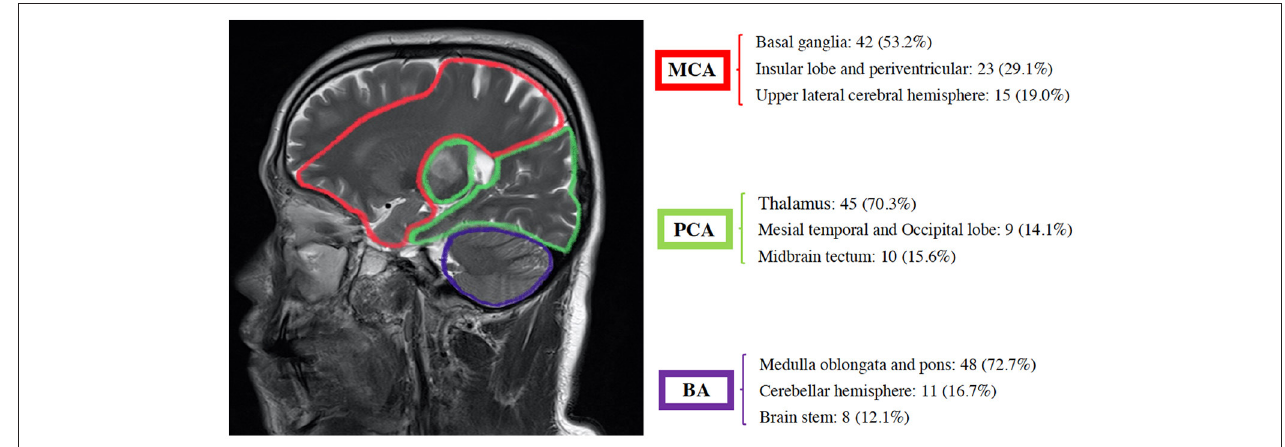
FIGURE 3 | Distribution characteristics of infarct lesions in each cerebral artery region.